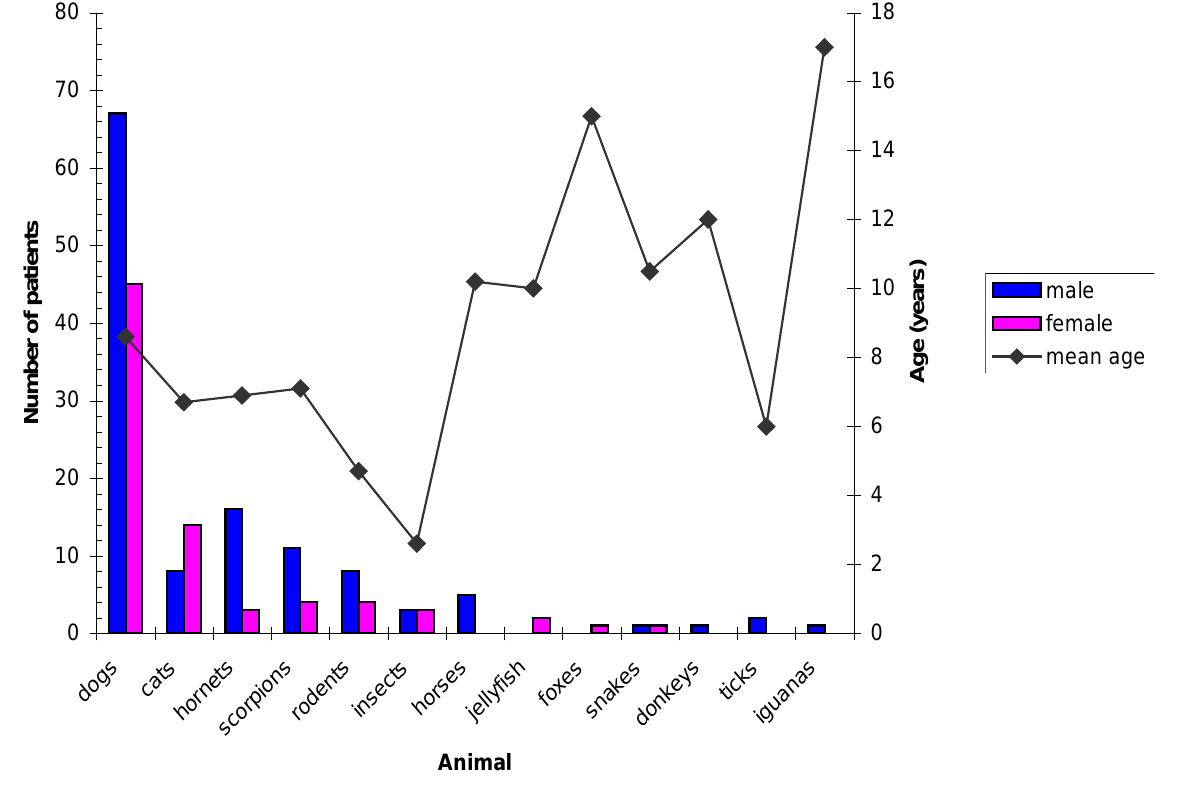
FIGURE 1 . Distribution of sources of pediatric bite/sting